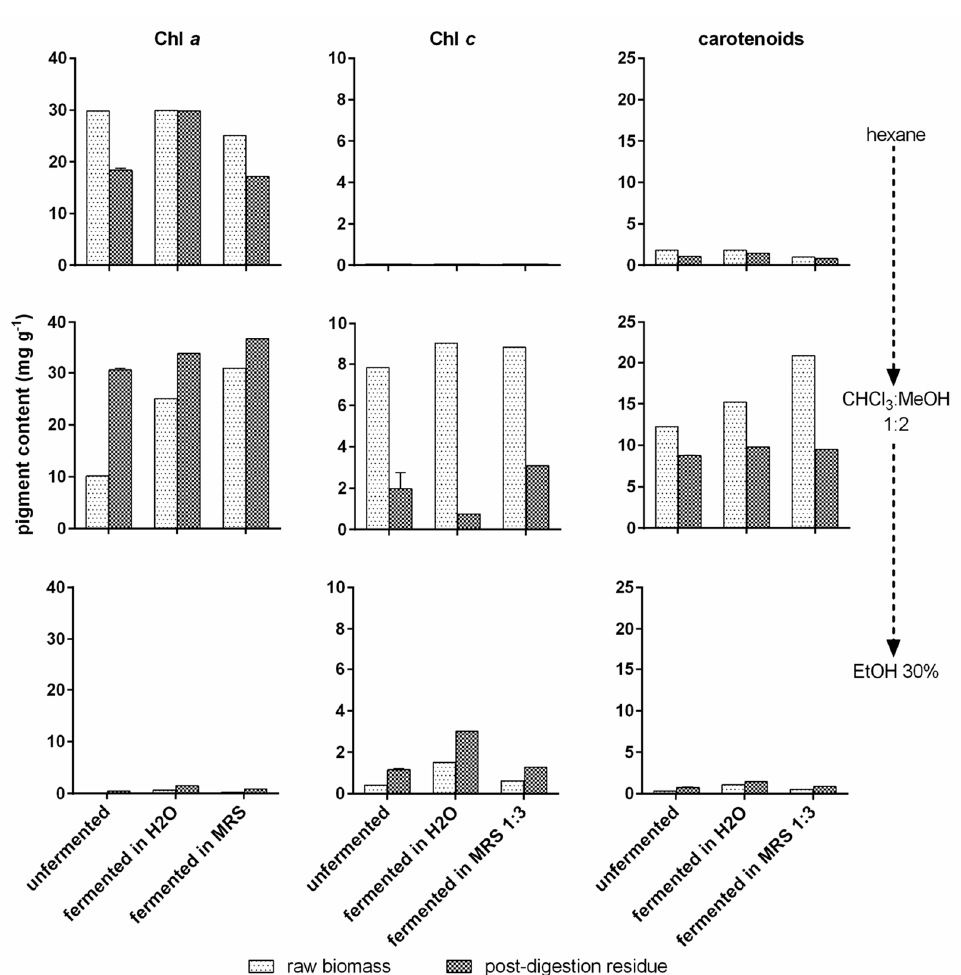
Figure 9. Pigment content in T. lutea F&M-M36 extracts. Chlorophyll a (Chl a ), chlorophyll c (Chl c ), and carotenoid content (mg g − 1 ) in T. lutea F&M-M36 raw biomass and post-digestion residue, unfermented and fermented in H 2 O or MRS 1:3, sequentially extracted with hexane, CHCl 3 :MeOH 1:2 and 30% EtOH. Data are expressed as mean ± standard error.